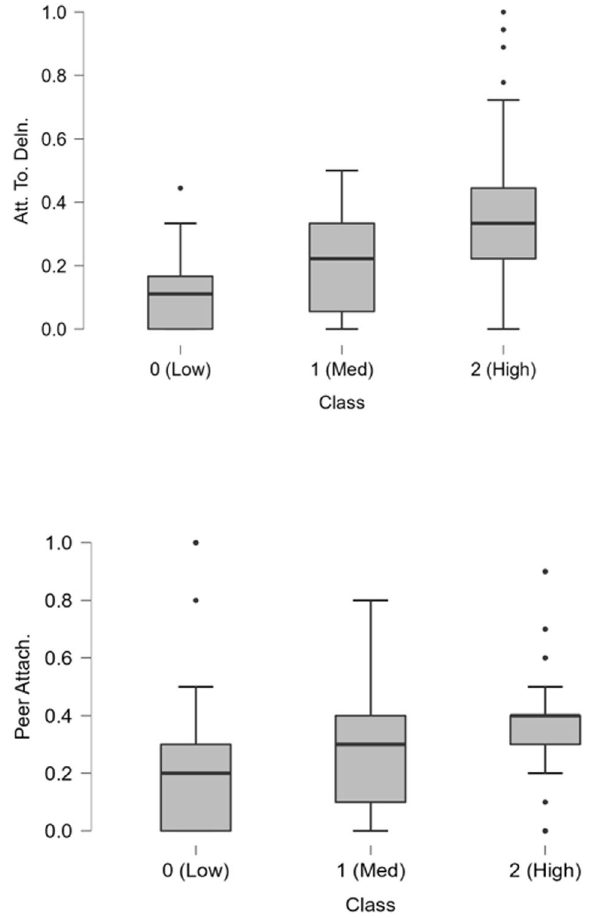
Fig. 4 The box plots of two major attributes viz. trip without permission and victimization. X -axis indicates the 3 classes and Y-axis indicates the given feature.